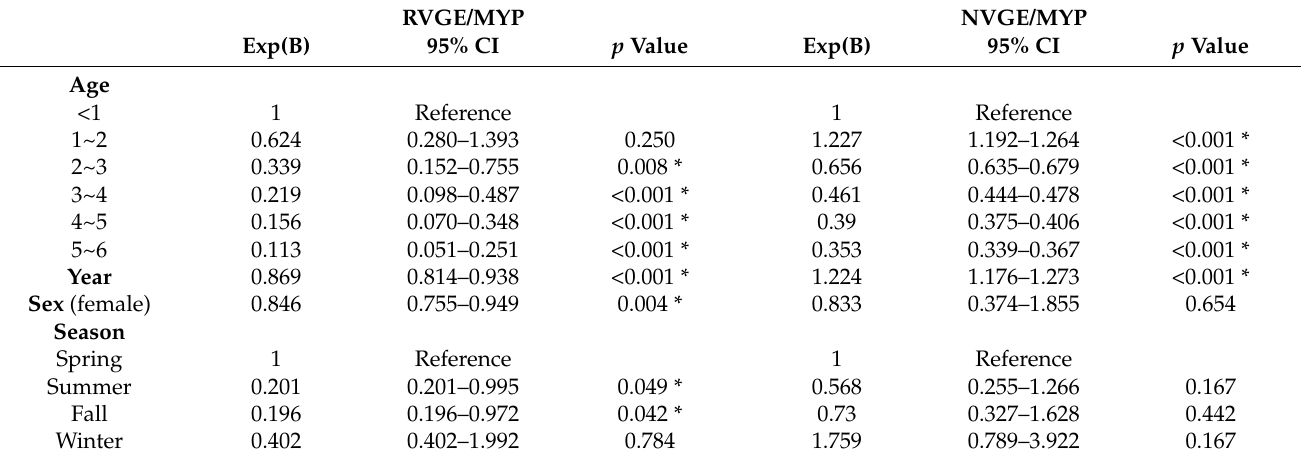
Table 3. Negative binomial regression analysis of patients with RVGE, patients with NVGE and the MYP.